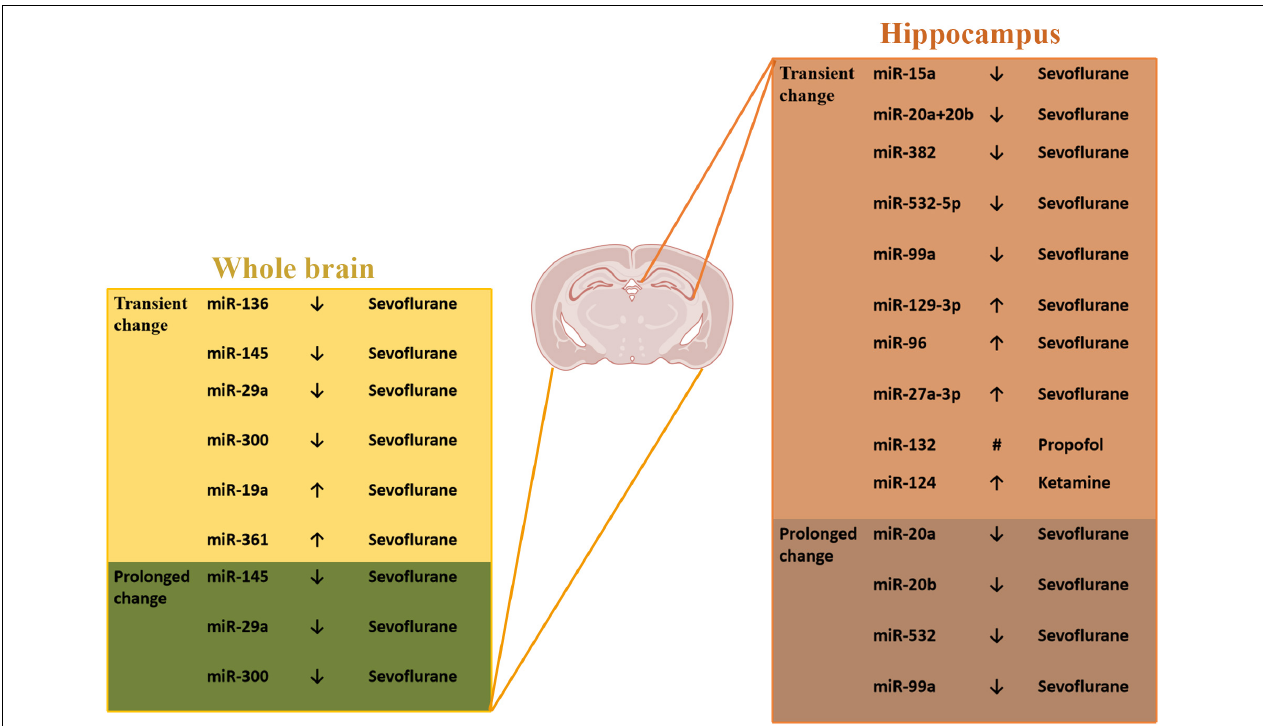
FIGURE 1 | The miRNAs expression changes induced by neonatal GA. # Different expression at different time points - decrease at 4, 8, and 48 h after the propofol treatment and at 14, 28, and 60 days of age; increase at 16 and 24 h after the propofol treatment.